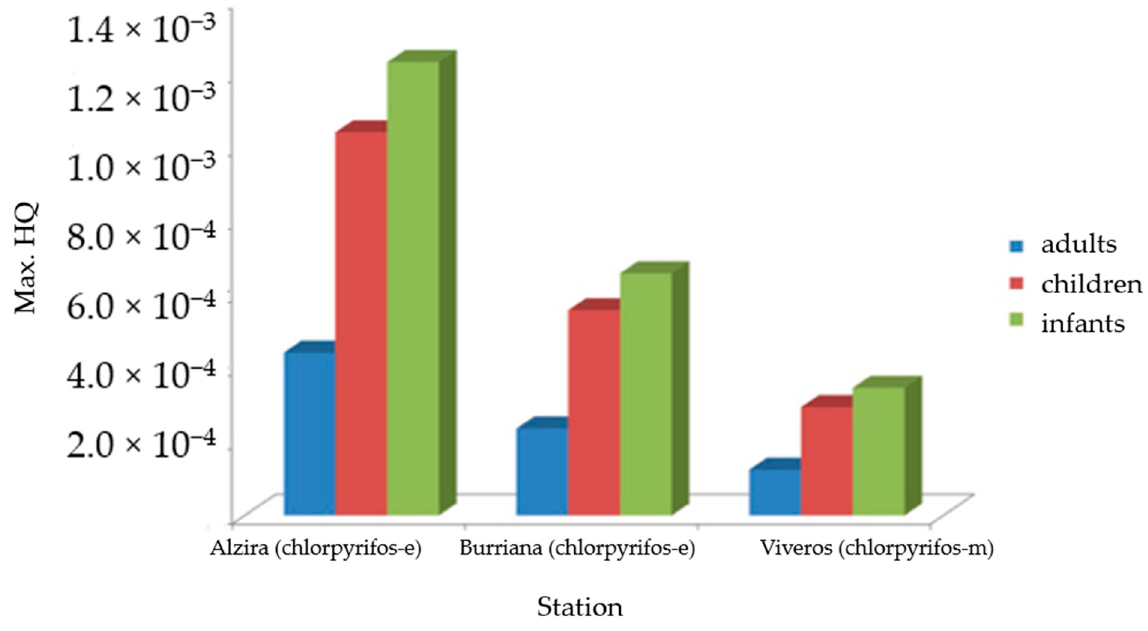
Figure 2. Maximum hazard quotient levels obtained in the different evaluated stations for adults, children, and infants in the Valencian region (Spain).